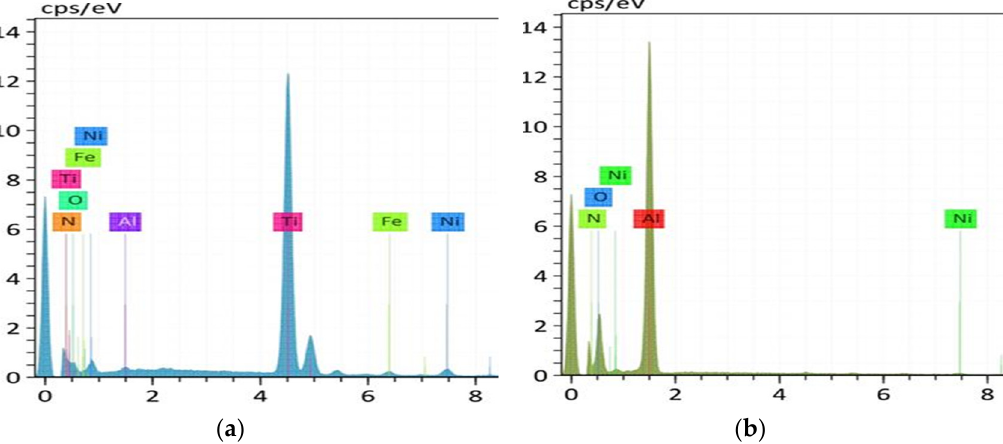
Figure 15. EDS image of the microgroove. ( a ) region on both sides of microgroove, ( b ) inner region with microgroove.